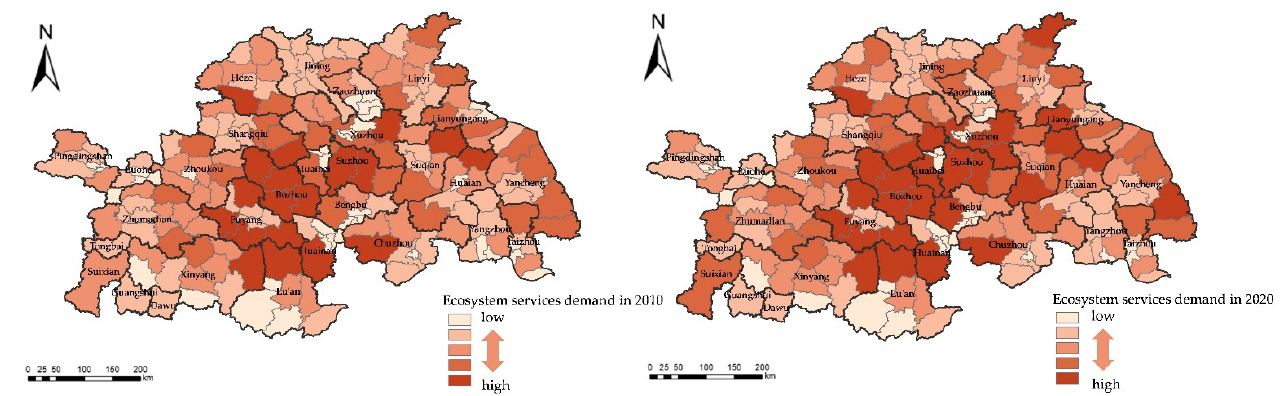
Figure 5. Spatial distribution of ecosystem service demand in the Huai River Basin.